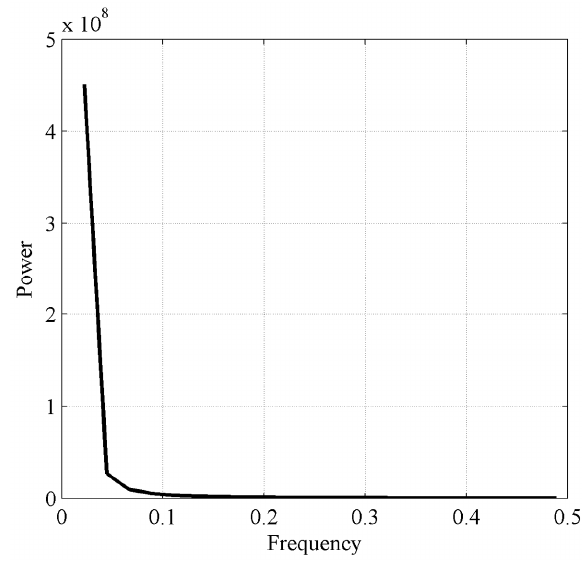
Figure 4. Power spectrum of IMF5 for Shangjingyou station.